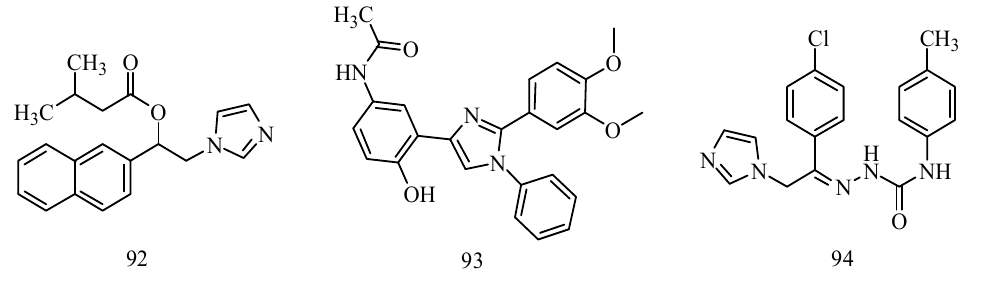
Figure 6. Structures of compounds 92 – 94 .